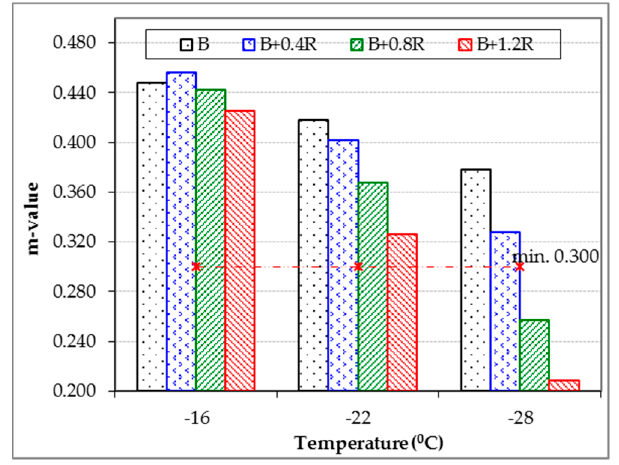
Figure 16. Effects of Elvaloy®RET on the m -value of B 160/220.